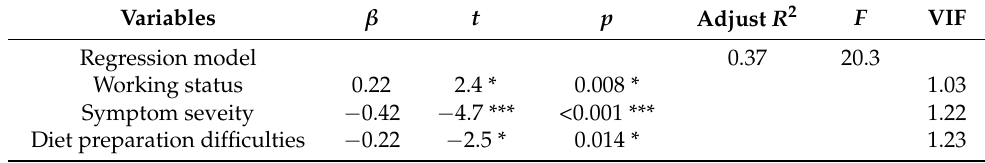
Table 5. Influencing factors of nutritional status in gastric cancer patients after gastrectomy.